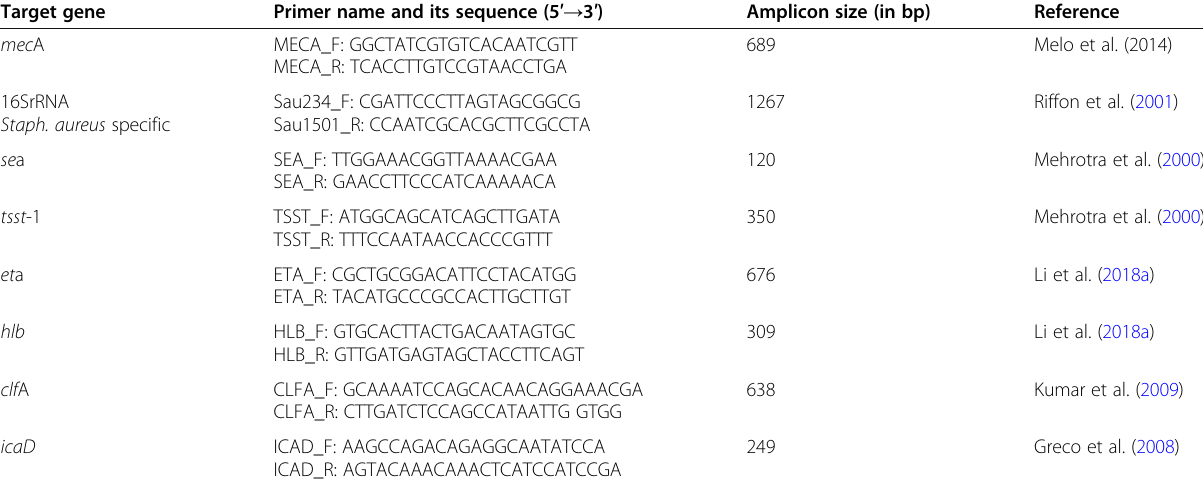
Table 1 Description of the primers used for molecular identification of different virulence-associated gene detection in S. aureus isolates Target